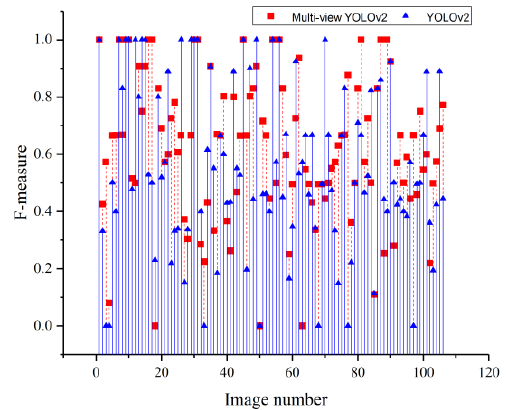
Figure 9. Comparison of the object retrieval abilities of the Multi-view YOLOv2 and classical YOLOv2 methods.